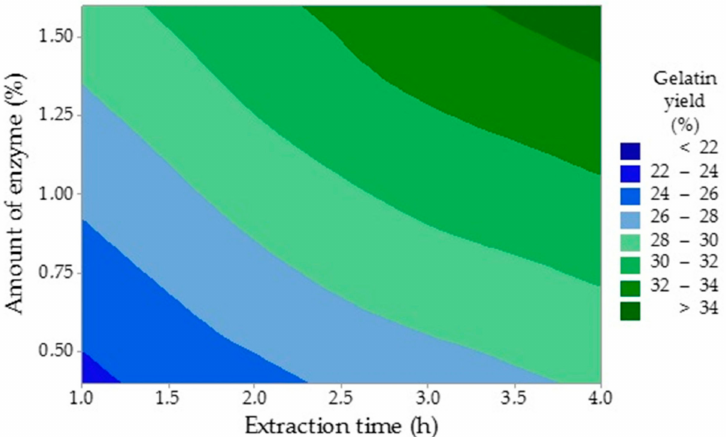
Figure 2. The influence of the time of extraction and the amount of enzyme on the yield of the first gelatin